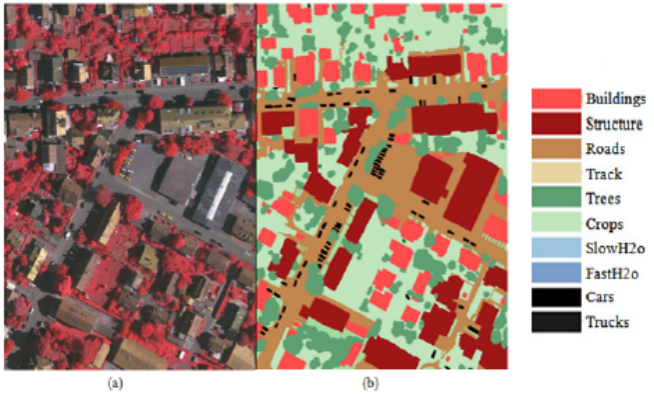
Figure 12. RGB images results: ( a ) the RGB image, ( b ) the result after classification. Figure 13 represents the result of our work on a 16-band image where image (a) indicates the real image scene and (b) is the results that the objects detected in these images which are buildings, cars, crops, fast H2O (rivers, sea), roads, slow H2O (lakes, swimming pool), structures, tracks, trees and trucks.